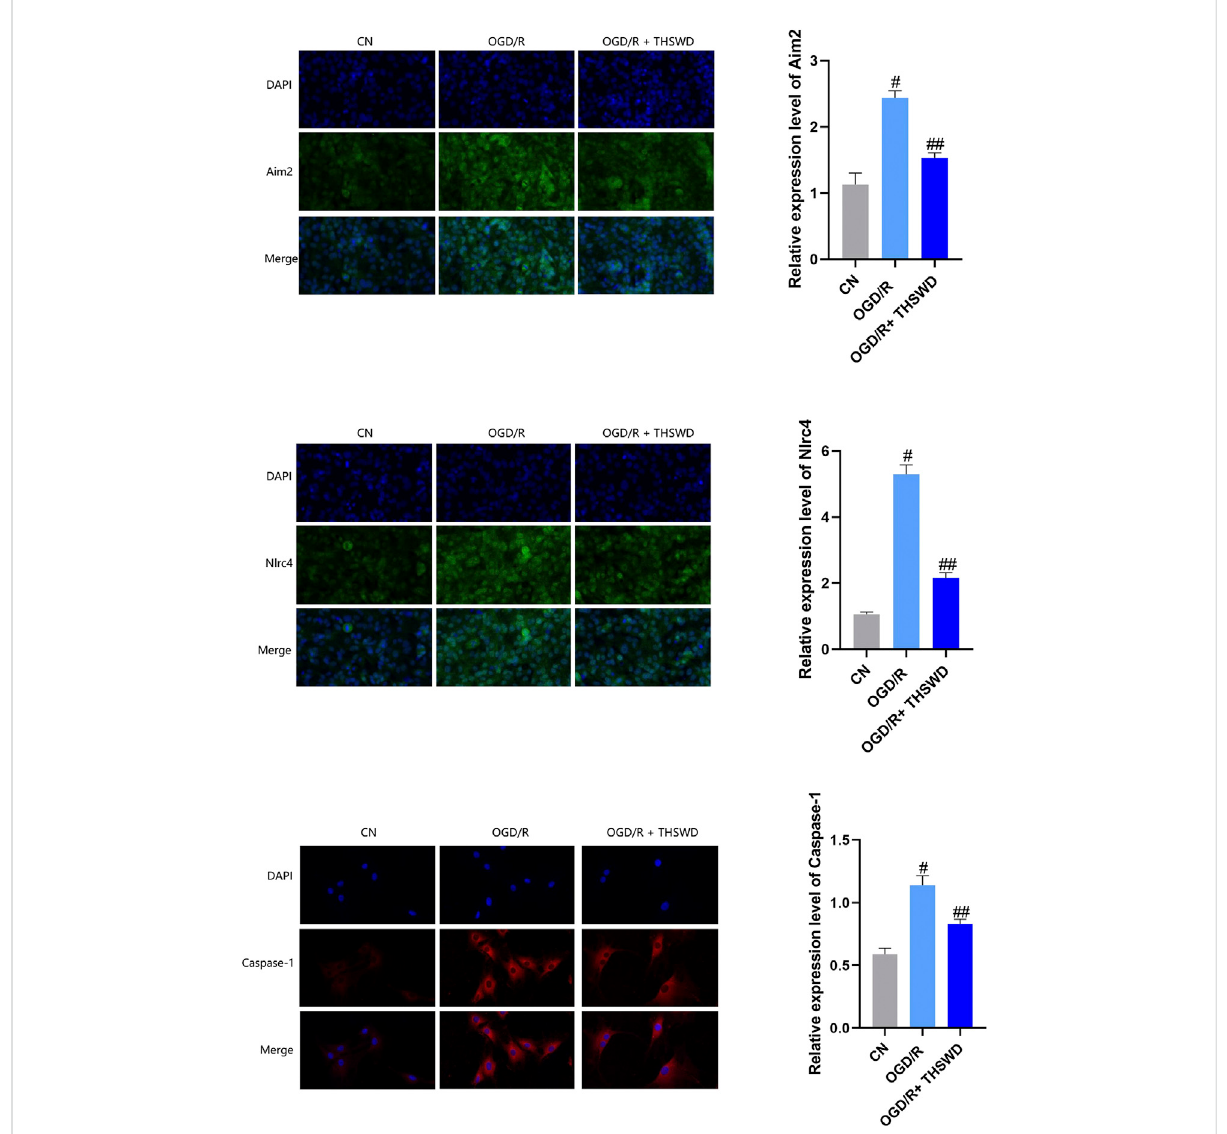
FIGURE 4 Expression of AIM2, NLRC4 and caspase-1 in fl ammasomes in cellular models. Notes: # p < 0.01 vs. Sham group; ## p < 0.01 vs. I/R